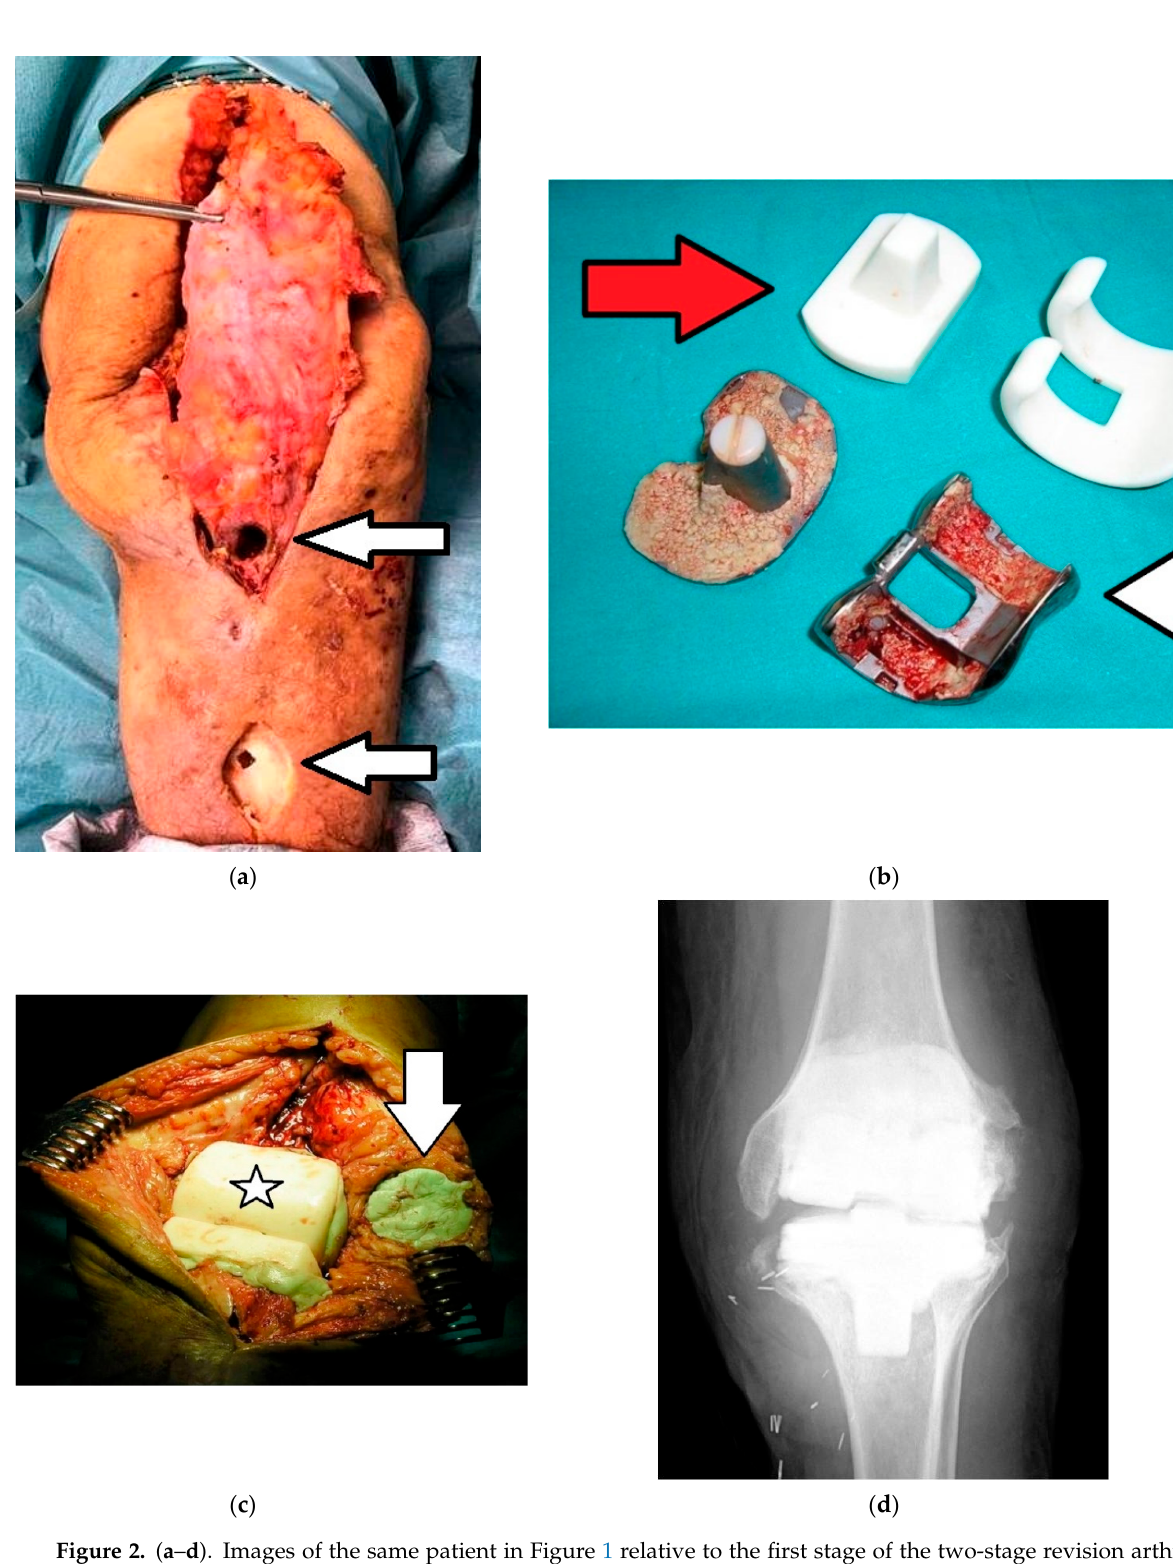
Figure 2. ( a – d ). Images of the same patient in Figure 1 relative to the first stage of the two-stage revision arthroplasty: ( a ) Image of the surgical field highlighting two fistulas caused by infection (arrows); ( b ) Femoral and tibial prosthetic components removed (white arrow) and antibiotic-loaded articulated spacer (red arrow) to implant; ( c ) Intraoperative image showing the articulated spacer already implanted (asterisk) and bone cement with gentamicin (green color) placed in the patellar component (arrow); ( d ) Postoperative radiograph showing the articulated spacer implanted.